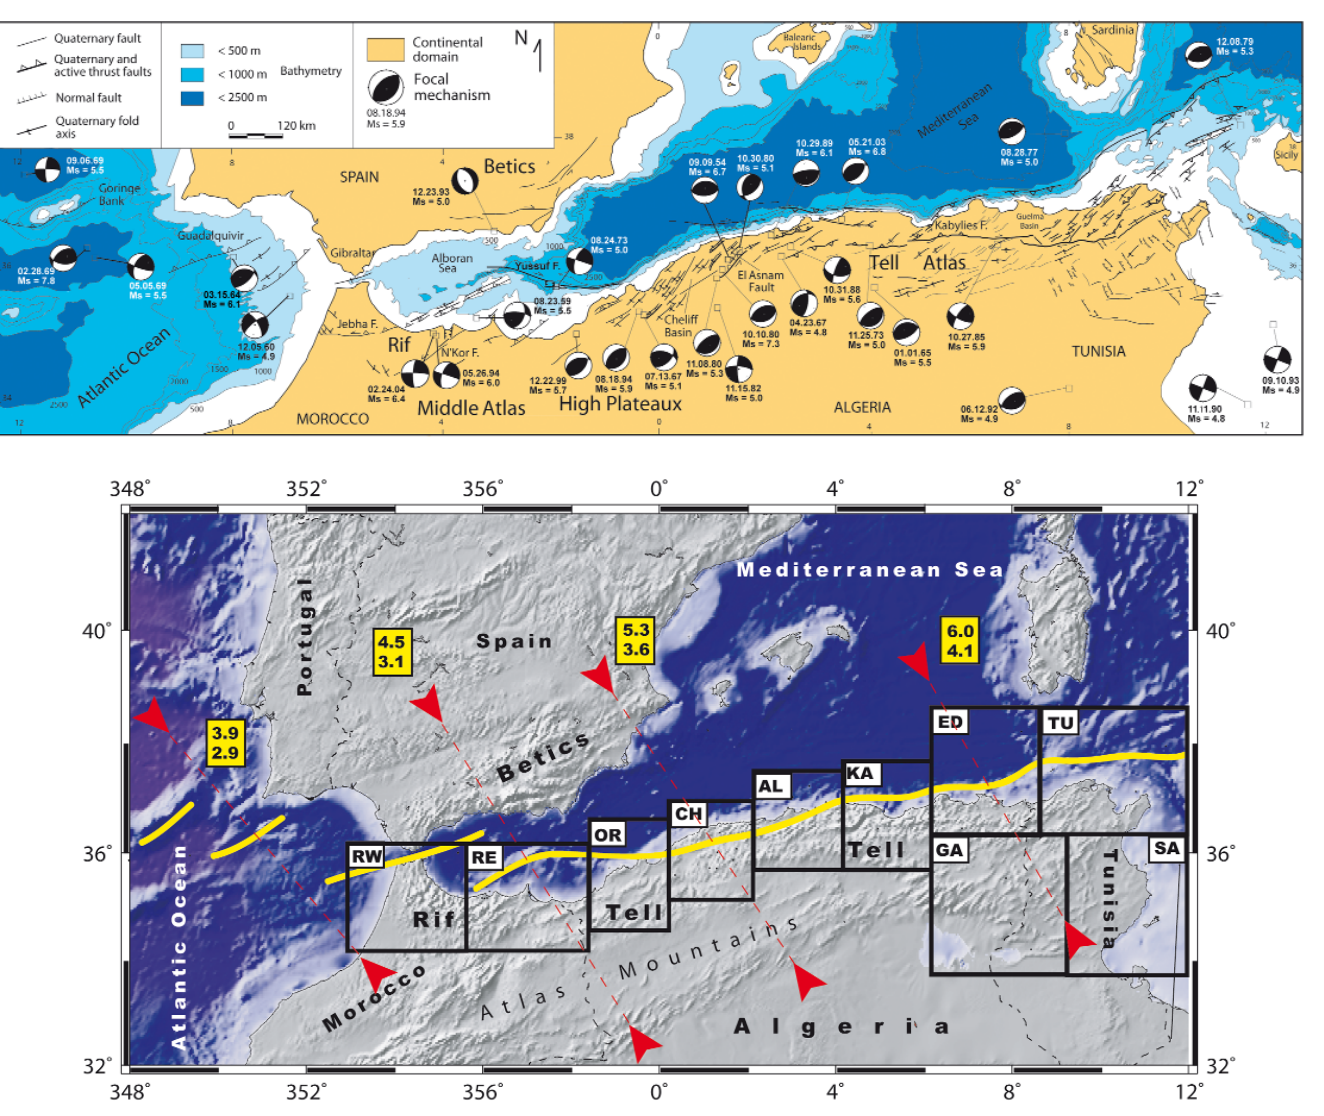
Figure 1. (a) Neotectonic and seismotectonic map along the Atlas mountains of North Africa [McKenzie 1972, Meghraoui et al. 1986, Dlala 1992, Rebai et al. 1992, Pondrelli et al. 1995, Meghraoui et al. 1996, Morel and Meghraoui 1996]. Quaternary tectonic structures characterize the recent compressional deformations along the plate boundary [Meghraoui 1988]. Focal mechanisms are CMTs [Dziewonski et al. 2000] of studied major seismic events in the Rif and Tell Atlas. (b) Definition of the 10 tectonic zones in the quadrants along the plate boundary, named as defined in the text and reported in Table 1: RW, Rif west; RE, Rif east; OR, Oran; CH, Cheliff; AL, Algiers; KA, Kabylia; ED, Edough; GA, Gafsa; TU, Tunis; SA, Sahel. The plate boundary is represented by the schematic yellow line (see also Figure 2c). The convergence directions from the global geodetic models (red arrows) with minimum and maximum convergence rates (yellow boxes) indicate an eastward increase [Nocquet and Calais